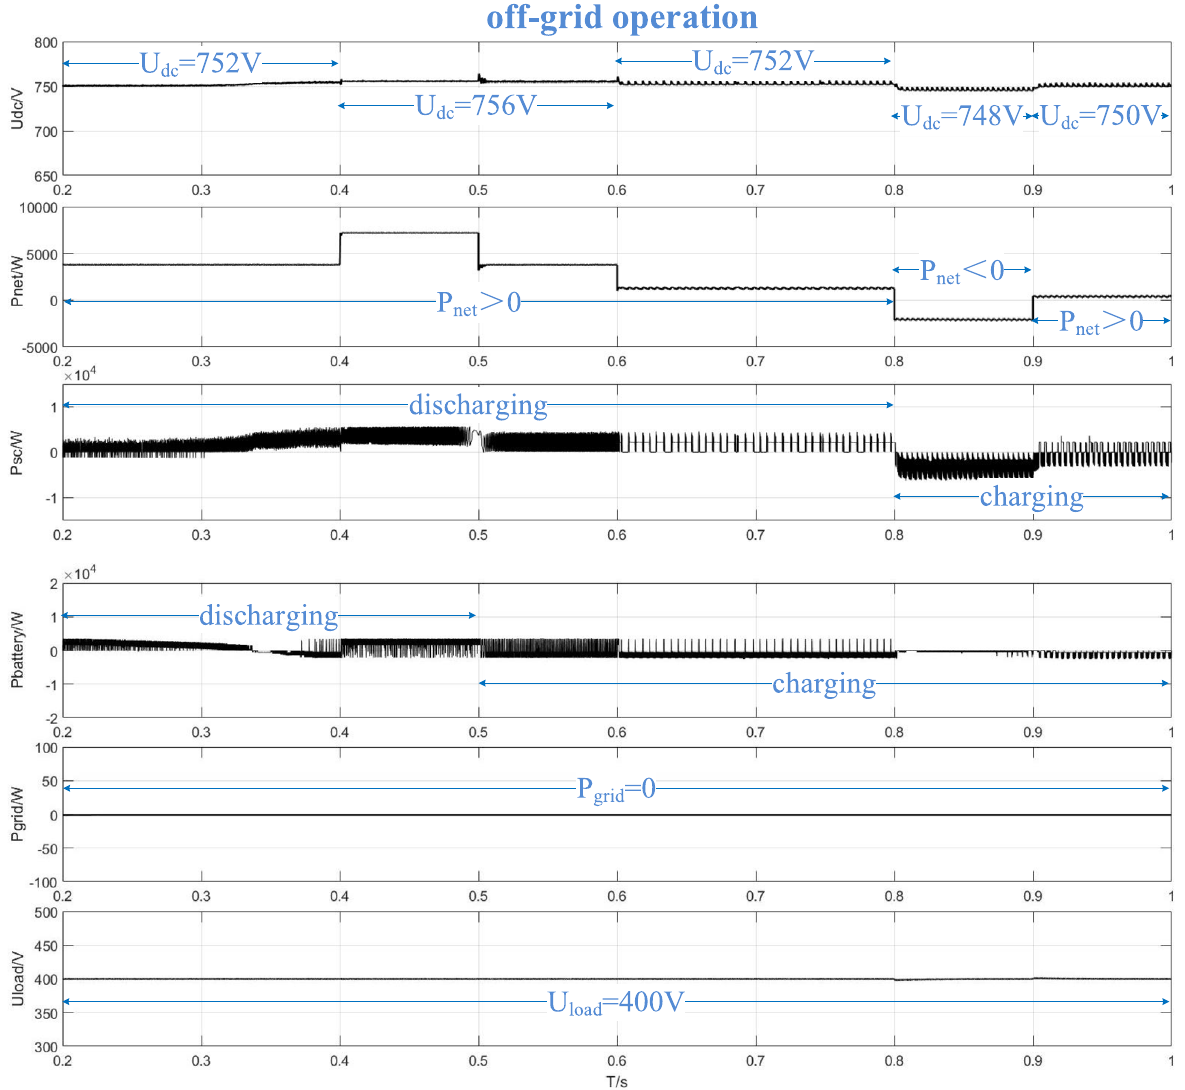
Fig. 13 Simulation results of off-grid